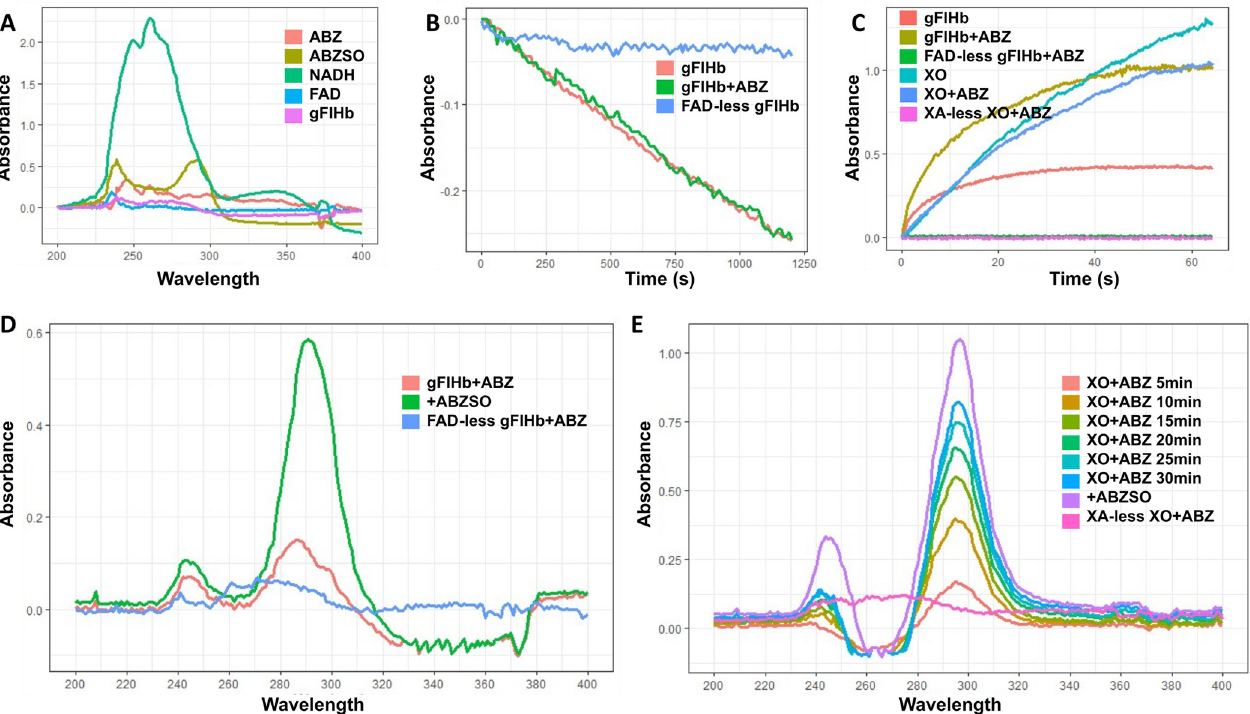
Fig 9. Spectral identification of ABZSO production by gFlHb. (A) Spectral characteristics of reagents, drugs and gFlHb (1.0 μ M). (B) NADH oxidase activities of recombinant gFlHb (0.36 μ M) in holo and FAD-less states and in the absence or presence of ABZ (150 μ M). (C) Superoxide formation during the enzymatic activity of gFlHb (0.176 μ M) and XO (0.176 μ M) both in holo and FAD-less or XA-less states, in the presence and absence of ABZ (150 μ M). (D) Detection of ABZSO by recombinant holo-gFlHb and FAD-less gFlHb (1.0 μ M). (E) Detection of ABZSO by XO (1.0 μ M) enzyme activity. Spectrum was determined at room temperature in 50 mM potassium phosphate buffer pH 7.5 in the presence (holoXO) or absence (XA-less XO) of 150 μ M xanthine.